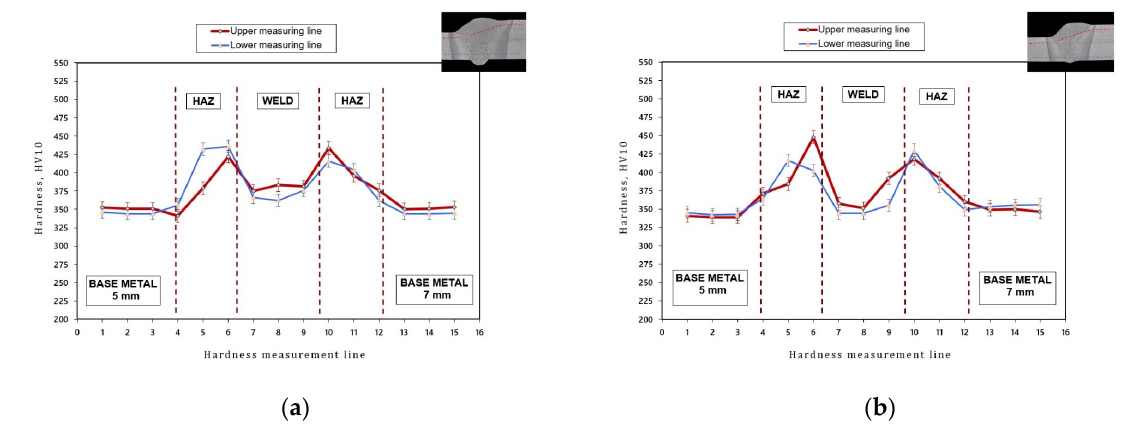
Figure 11. Measurement results and the distribution of hardness in the cross-section of the HLAW joint: ( a ) joint no. 1 (PA) and ( b ) joint no. 2 (PC).